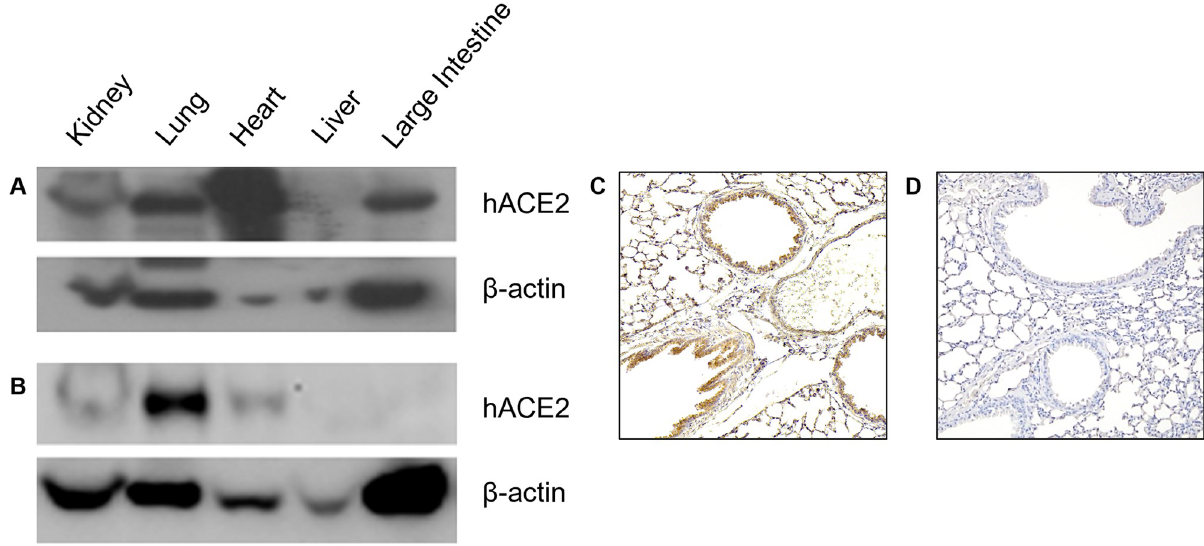
Fig 1. hACE2 expression profile in multiple organs of K18-hACE2 and CAG-hACE2 transgenic lineage. Elevated levels of hACE2 were detected in the lungs of both K18-hACE2 and CAG-hACE2 transgenic lineages. (A) Western blot analysis of hACE2 expression in multiple organs of CAG-h ACE2; (B) Western blot analysis of hACE2 expression in multiple organs of K18-hACE2; (C) Immunohistochemistry analysis of hACE2 expression in the lungs of K18-hACE2; (D) Immunohistochemistry analysis of hACE2 expression in the lungs of mock control.